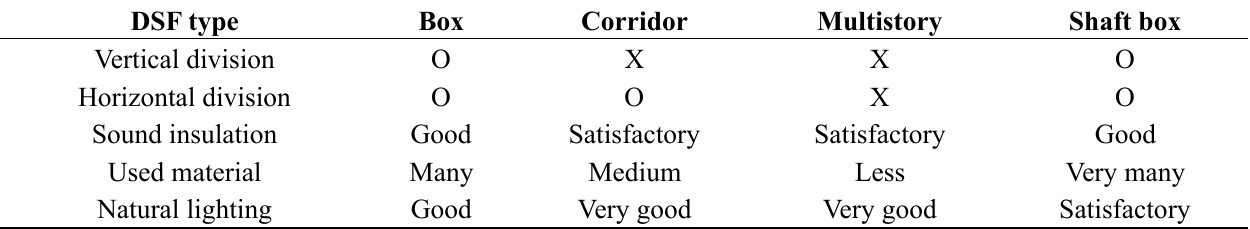
Table 1. Characteristics of the four types of DSF.